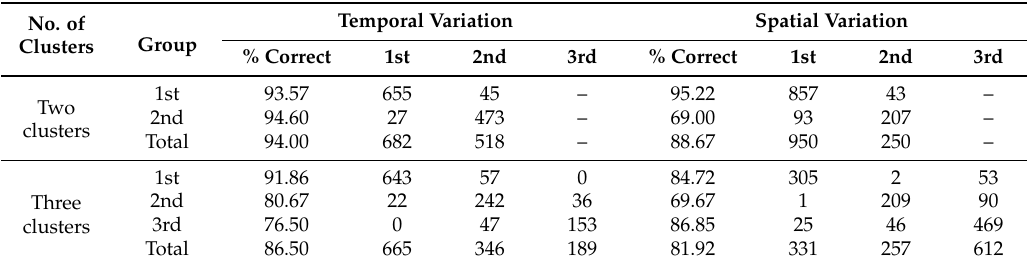
Classification matrices for backward discriminant analysis (DA) of temporal and spatial